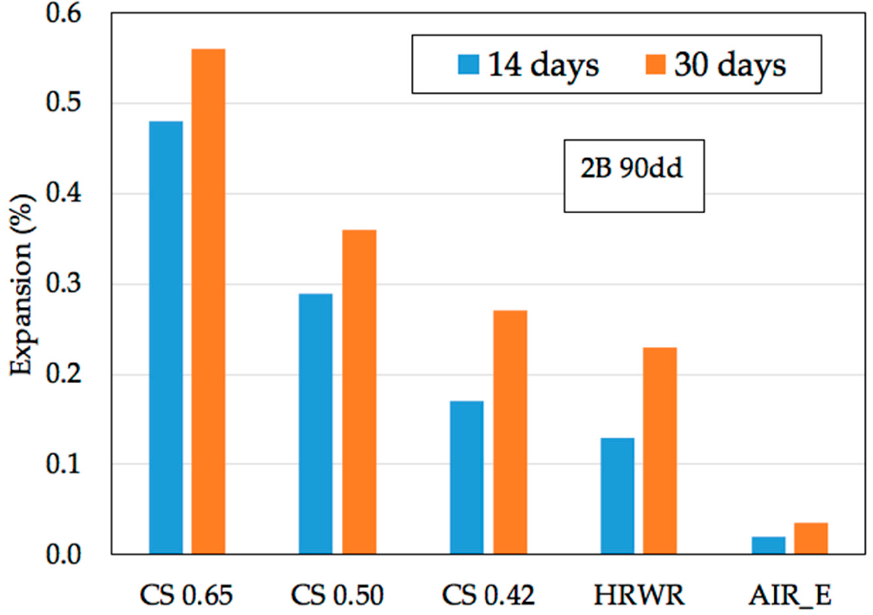
Figure 7. Expansion according to Procedure 2B, relative to mortars cured for 90 days.